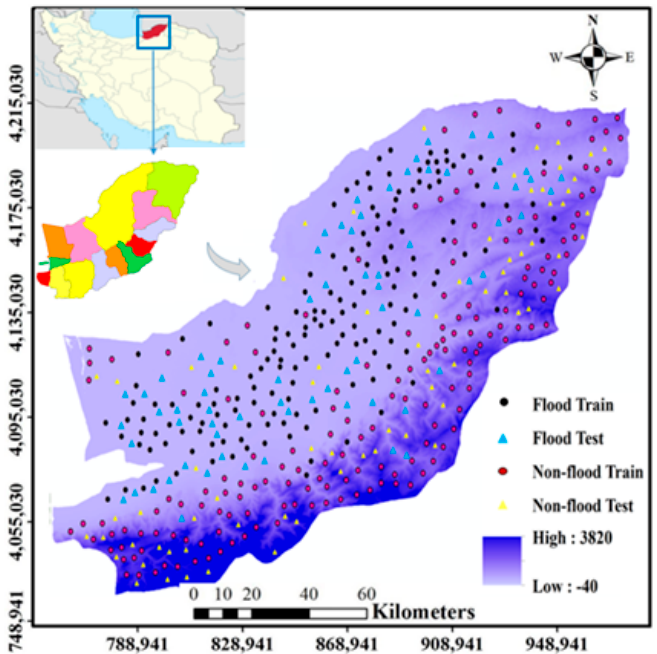
Figure 1. The case study: Golestan Province, Iran.